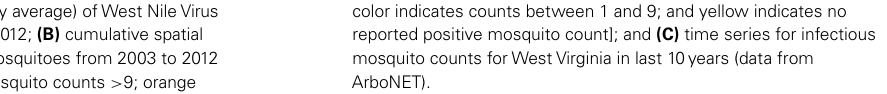
color indicates counts between 1 and 9; and yellow indicates no reported positive mosquito count]; and (C) time series for infectious mosquito counts forWestVirginia in last 10years (data from